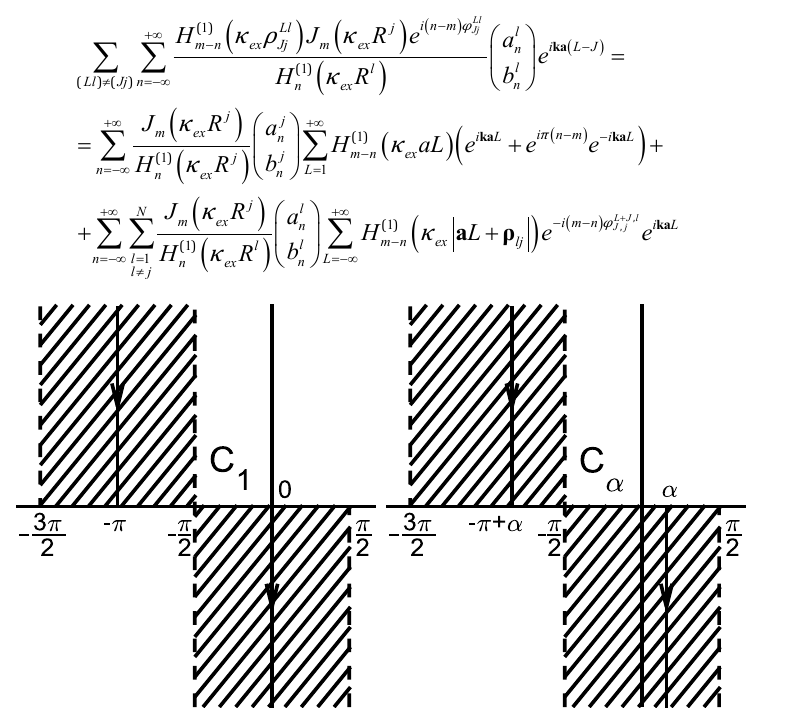
Fig. 1. The integration contours. The regions where integral is convergent are